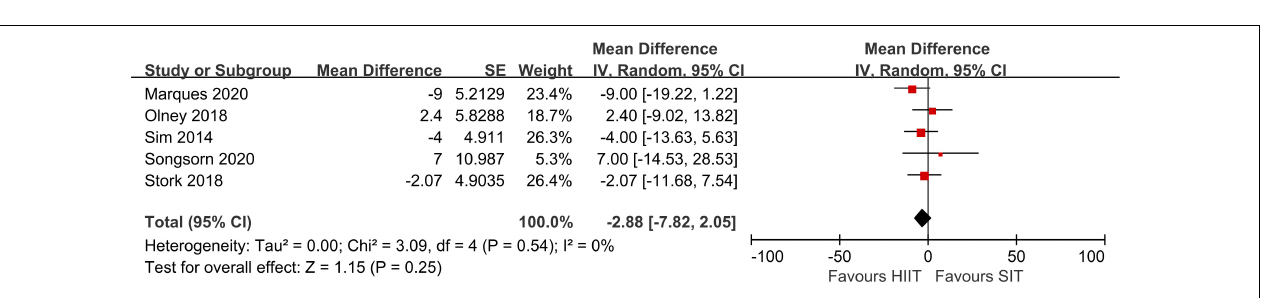
FIGURE 6 | Random effects meta-analyses for the influence of sprint interval training vs. high-intensity interval training on enjoyment. Effect sizes are shown as mean difference and 95% confidence